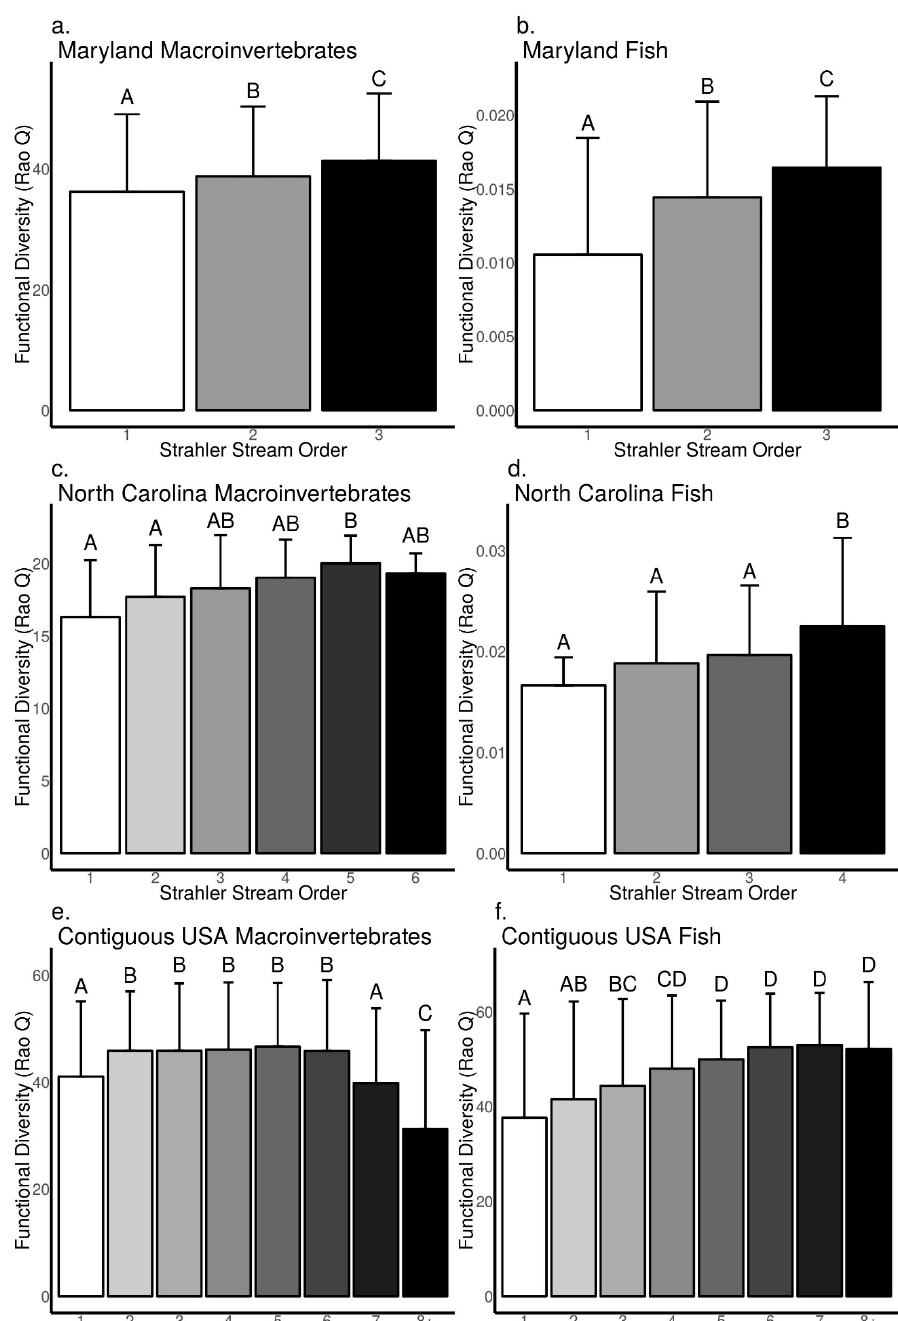
Figure 6. Relationship between functional diversity (Rao Q) and Strahler stream order for macroinvertebrate ( a , c , e ) and fish ( b , d , f ) communities collected from Maryland (MBSS), North Carolina (NCBMP) and contiguous USA (USEPA). Error bars represent standard deviation and different letters indicate significant differences between orders determined using Tukey’s HSD multiple comparisons.